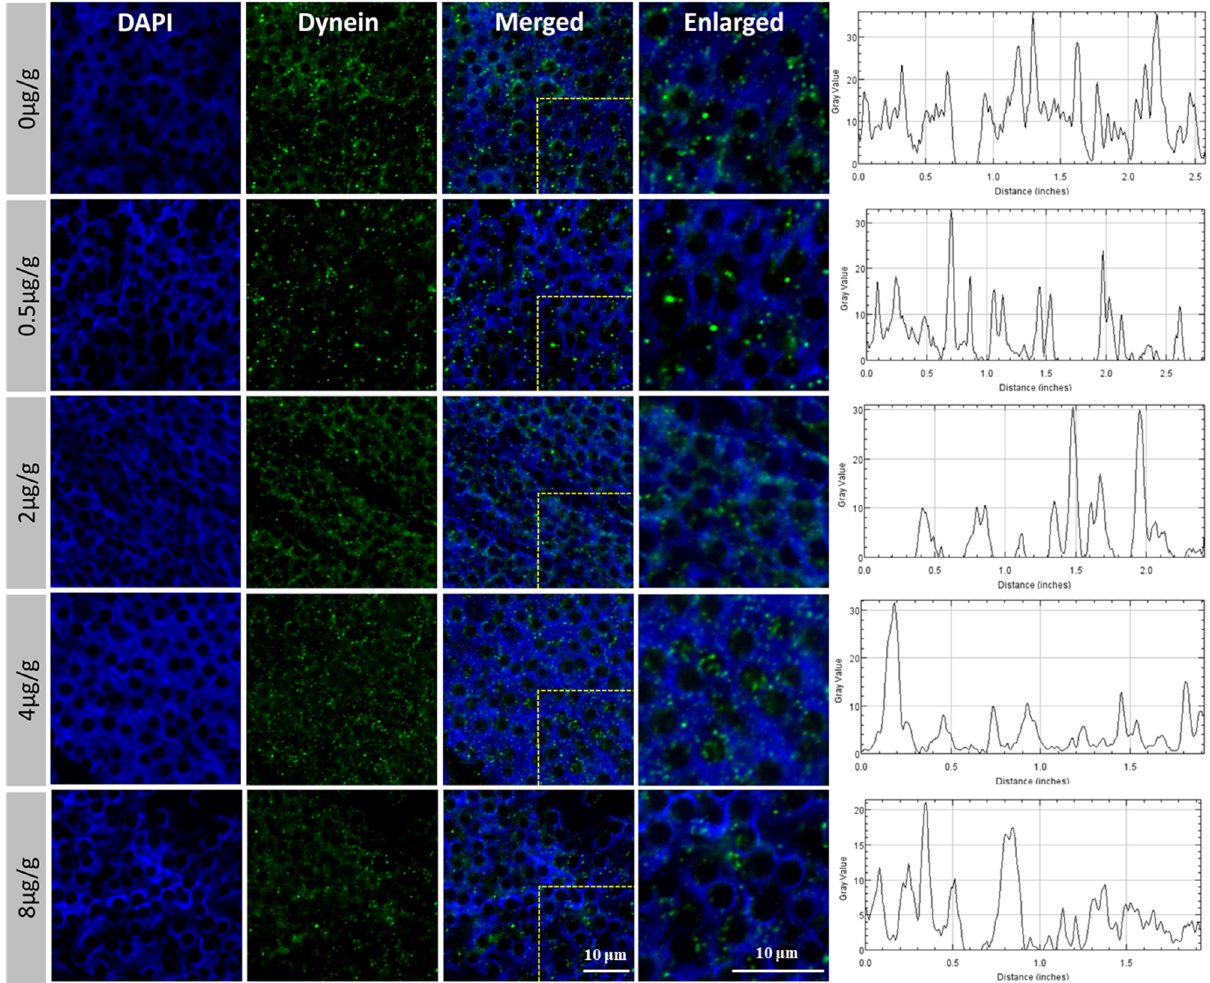
Figure 4. Pt- DHC distribution of mature sperm in the testis of P. trituberculatus treated with different concentrations of SOV. In the control group and 0.5 μ g/g group, dynein is mainly distributed at the front end of the acrosome. Additionally, in the 2.0, 4.0 and 8.0 μ g/g groups, dynein is dispersed in cytoplasmic regions. Green fluorescence is dynein ( Pt- DHC) and blue fluorescence is the nucleus. Bar = 10 μ m.